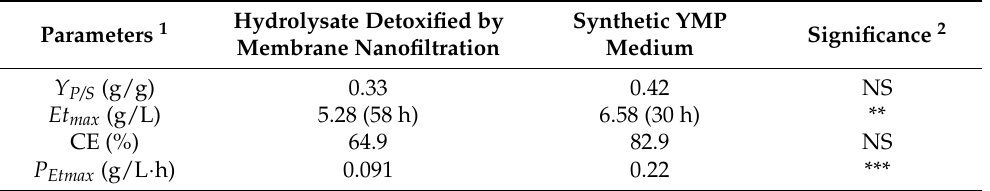
Table 3. Kinetic and stoichiometric parameters obtained in the fermentations by S. stipitis using the synthetic YMP medium and the hydrolysate detoxified by